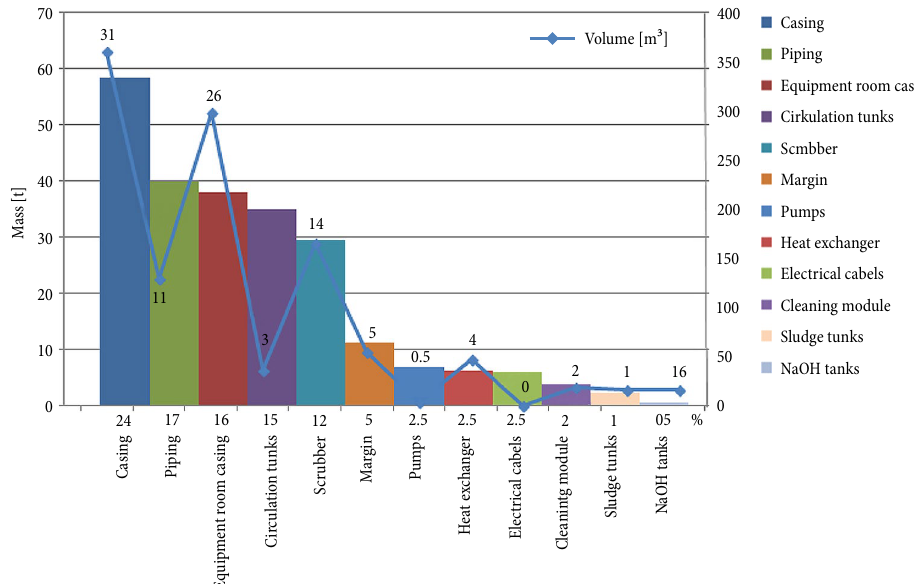
Fig. 4. The mass and volume of each element of scrubber system